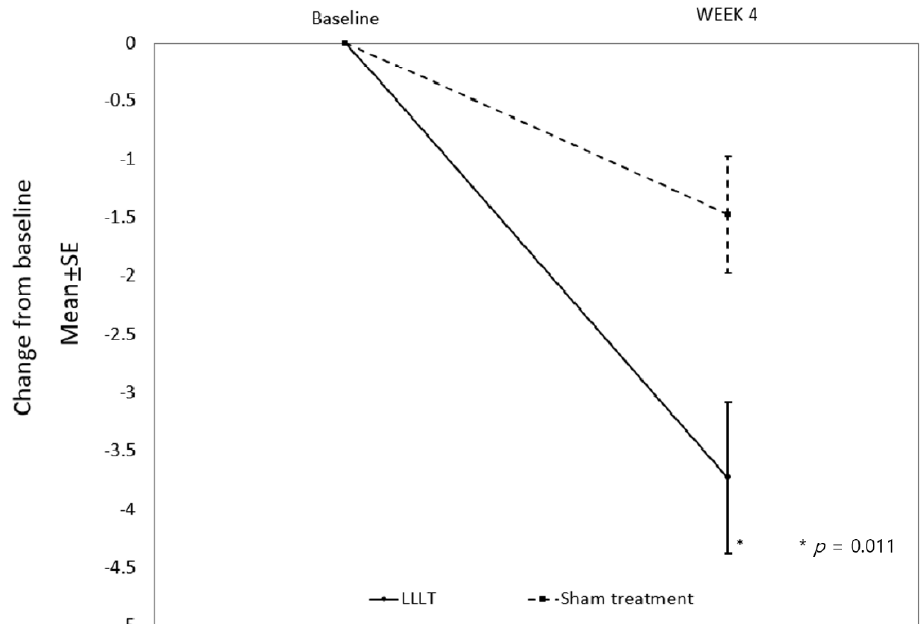
Figure 3. Least square means (LSMeans) in the TNSS from baseline to the end of treatment.